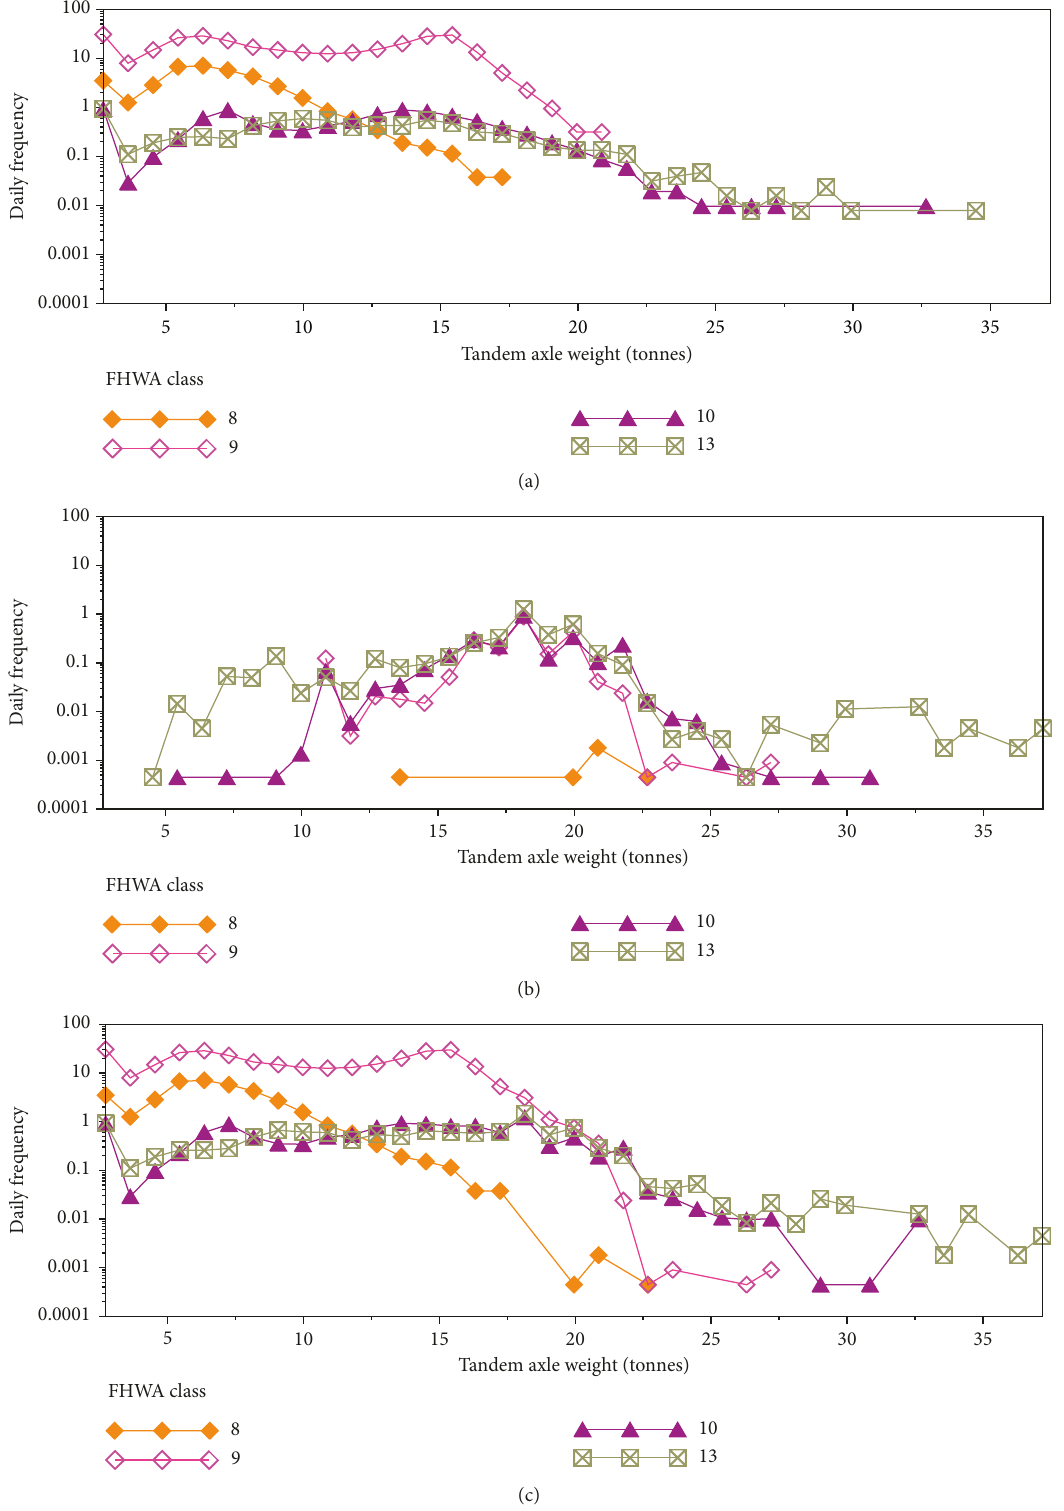
Figure 6: ALS for tandem axles developed for ME analysis of pavement on STH 140. (a) Tandem ALS frequency on STH 140 for baseline truck traffic, (b) tandem ALS frequency on STH 140 for OW permit vehicles, and (c) tandem ALS frequency on STH 140 for meshed traffic (baseline and OW trucks). Note: vehicles from classes 7, 11, and 12 are excluded due to very low frequencies of tandem